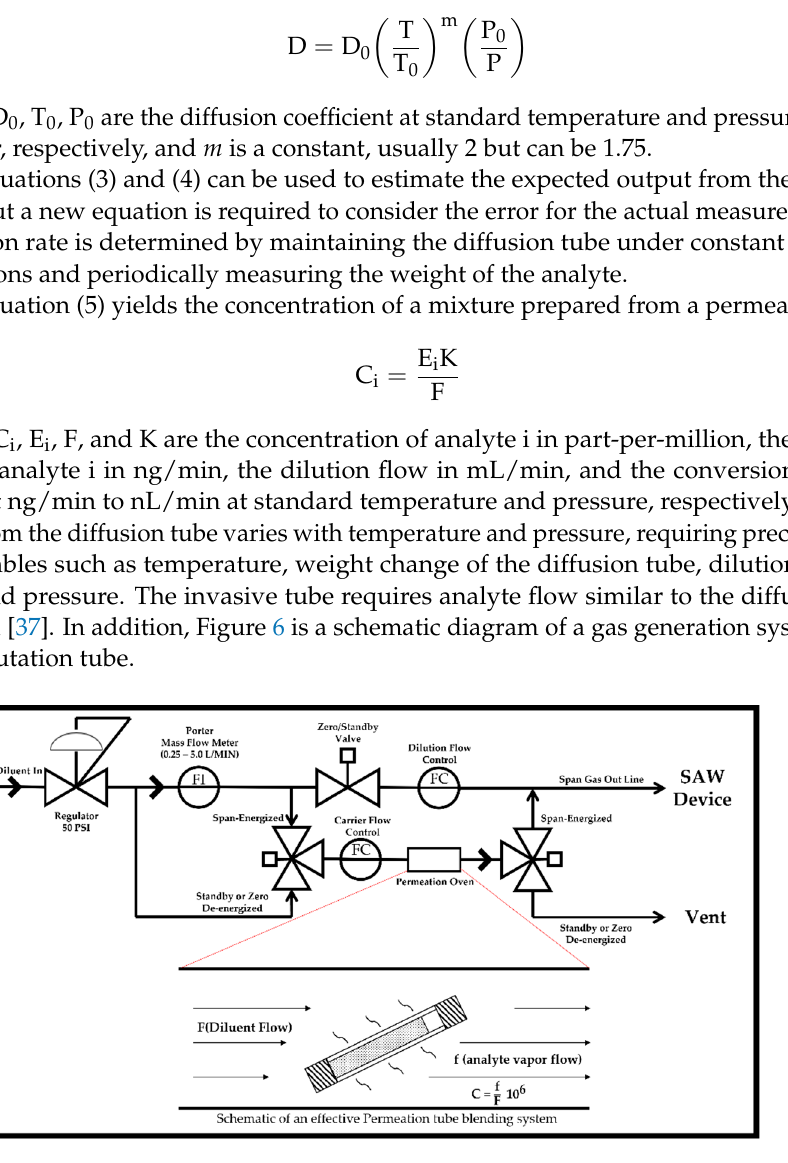
Figure 6. Gas feeding system: Base Module Flow Diagram for the permeation tube and schematic of and effective permeation tube blending system from KIN-TEK [37,38].